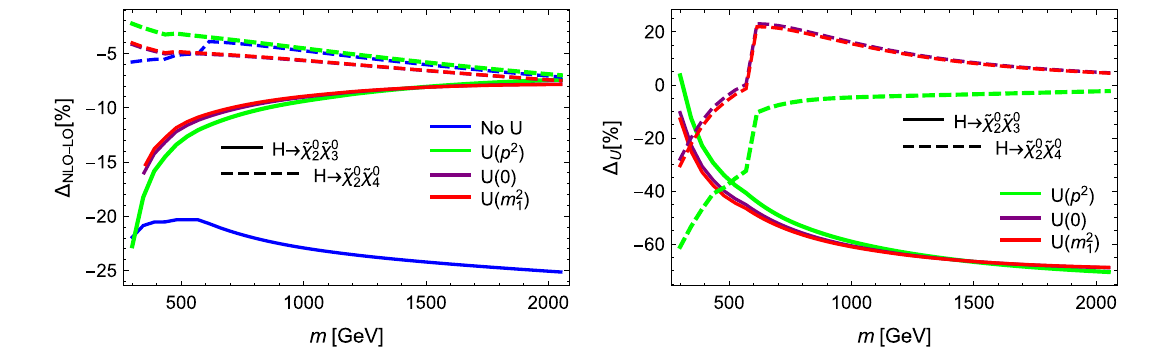
Fig. 11 Same as Fig. 9 for decays of the heavy CP -even Higgs boson